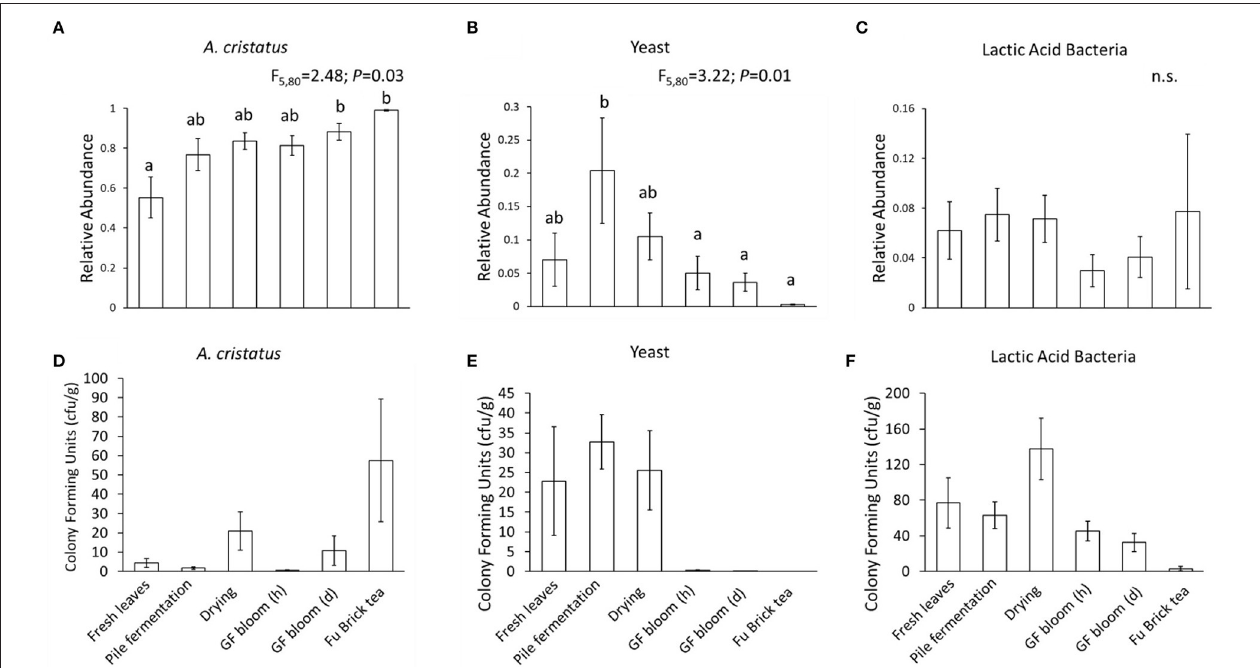
FIGURE 4 | Bar plots showing the relative abundances (A–C) and colony forming units (D–F) of A. cristatus golden flower fungus, yeasts, and lactic acid bacteria, respectively, based on culture-dependent analysis at each examined stage of Fu Brick manufacturing. Standard errors from the mean for each stage are shown with each bar. Statistical results following linear mixed models (A-C) are presented above each panel. “n.s.” indicates no significant effect. Letters above bars indicate significant differences between manufacturing stages. “GF bloom (h)” is the early stage golden flower bloom and “GF bloom (d)” is the full golden flower bloom.